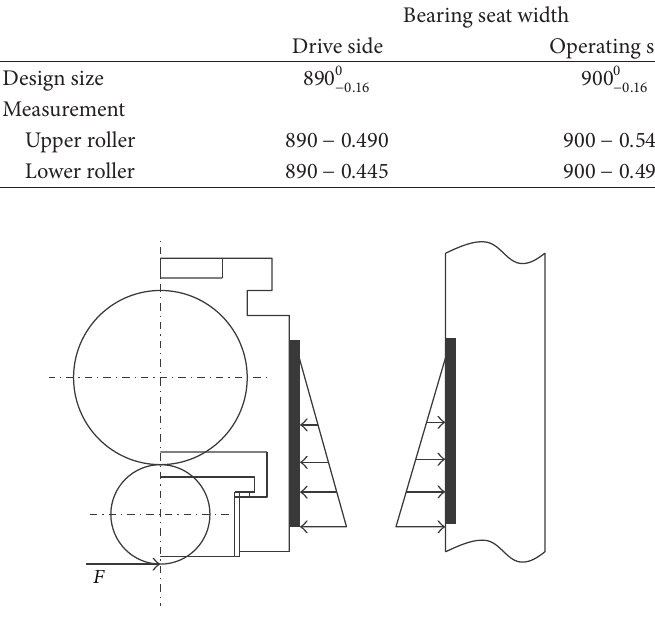
Figure 4: Bearing seat and mill house force diagram.